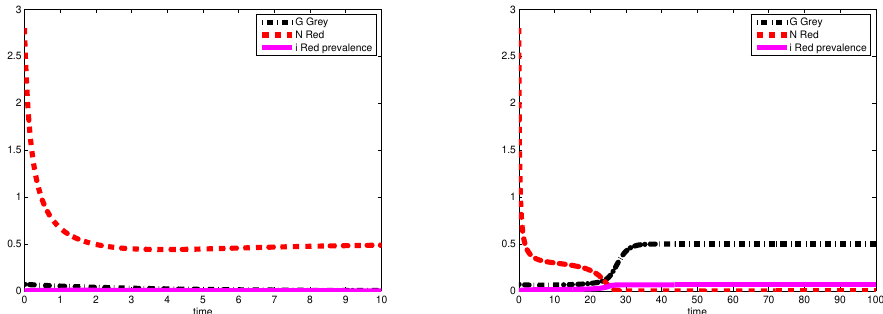
Figure 9. ( Left frame ) Native squirrels are preserved, and disease, as well as invaders are eradicated with very low prevalence for r = 0.3, E = 0.5, µ = 10.0, β = 0.6. ( Right frame ) Invader squirrels thrive while the natives disappear, with the disease remaining endemic, through r = 0.58 and the remaining values as before.